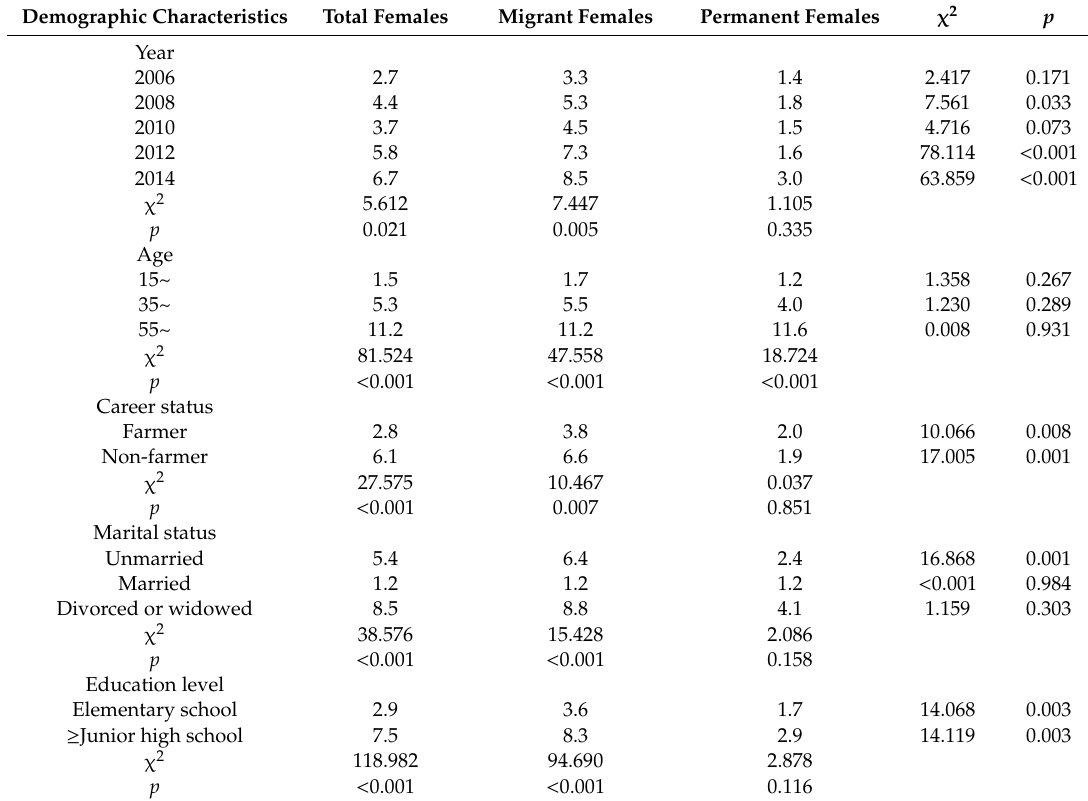
Table 3. The hospitalization rate due to illnesses of female among total females, migrant females, and permanent females (%)